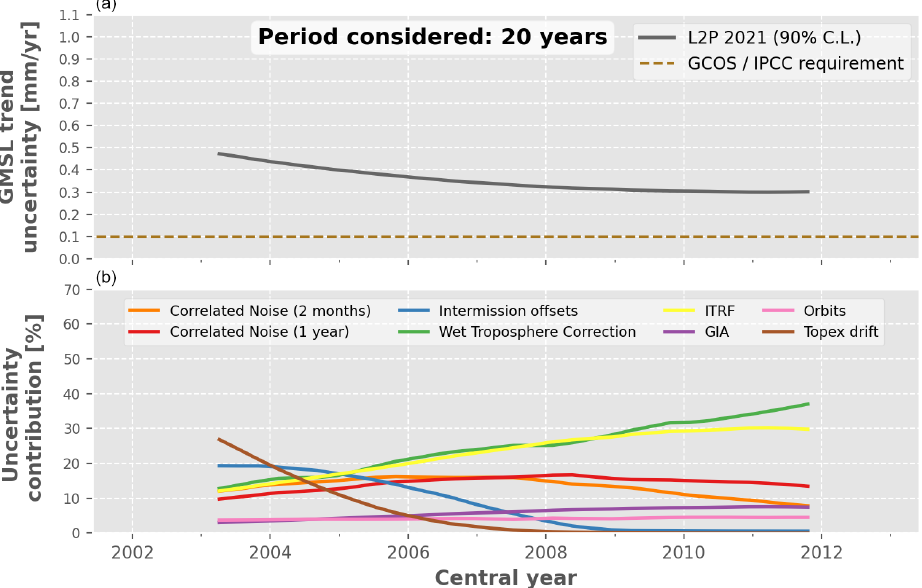
Figure 9. Relative contribution of each uncertainty budget contributor to the GMSL trend uncertainty over periods of 20 years. (a) GMSL trend uncertainty in the L2P21 record. The horizontal dashed brown line shows the GCOS/IPCC requirement for the GMSL trend stability, i.e. 0.1myr − 1 (90%C.L.). (b) Relative contribution to the total GMSL trend uncertainty (%) of each uncertainty budget contributor, i.e. the altimeters, the radiometers, the orbit determination and the geophysical corrections.